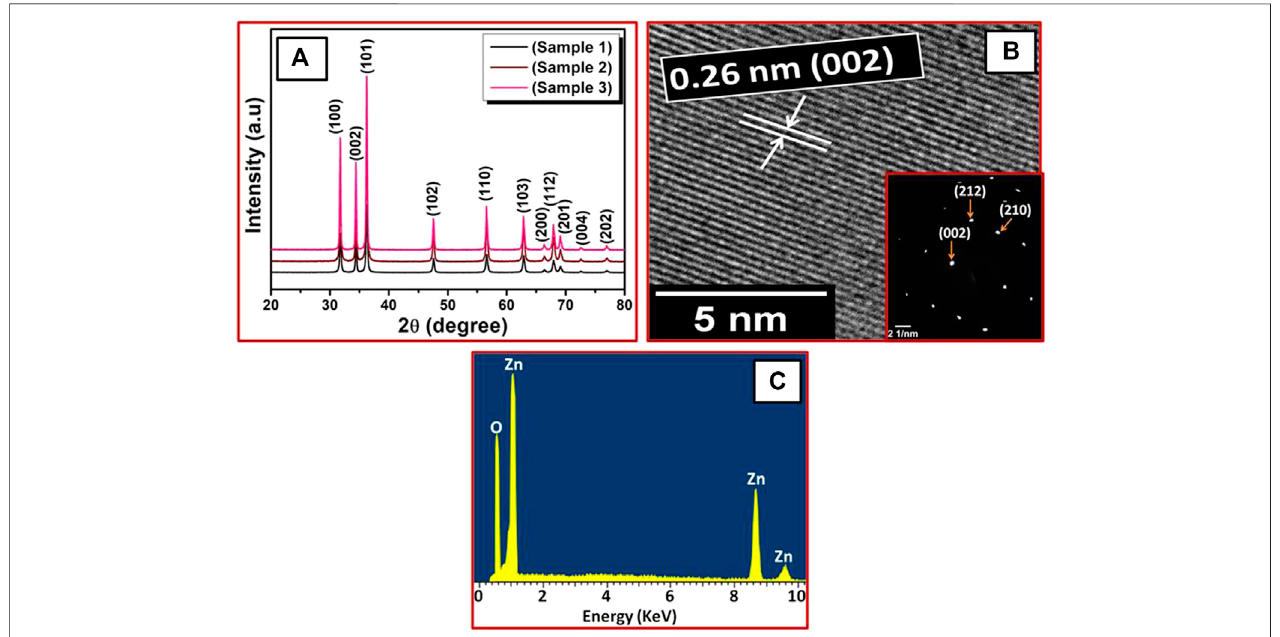
FIGURE1|(A) XRDpatternsofZnOnanosheets fordifferentmolarratiosofzinc acetateand KOH:sample1(1:2.5),sample2(1:2.75),sample3(1:5). (B) HRTEM and SAED patterns of sample 1, (C) corresponding EDX spectrum.